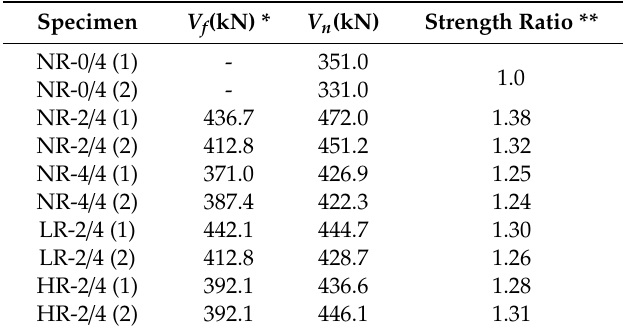
Table 4. Cracking loads and web-shear strengths of test